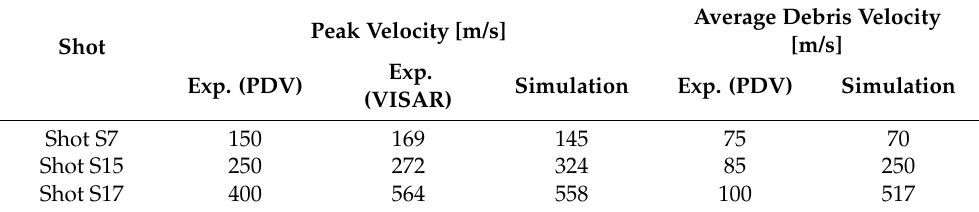
Table 4. Comparison between the speed data of the PDV and VISAR measurements from (adapted from [28]) and of the numerical